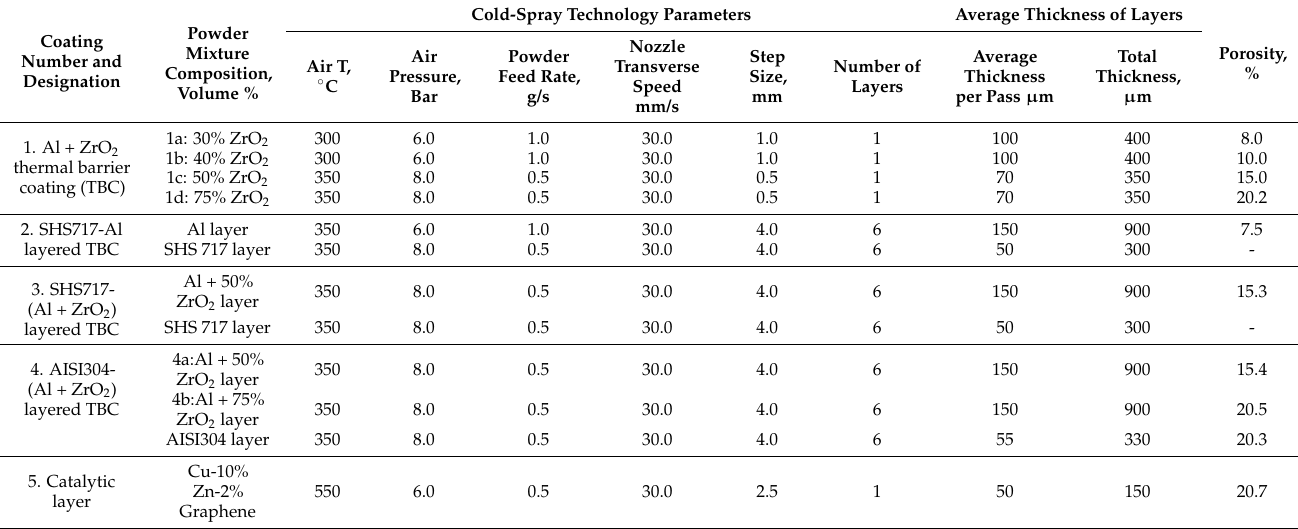
Table 1. Cold-spraying technology and deposited coating